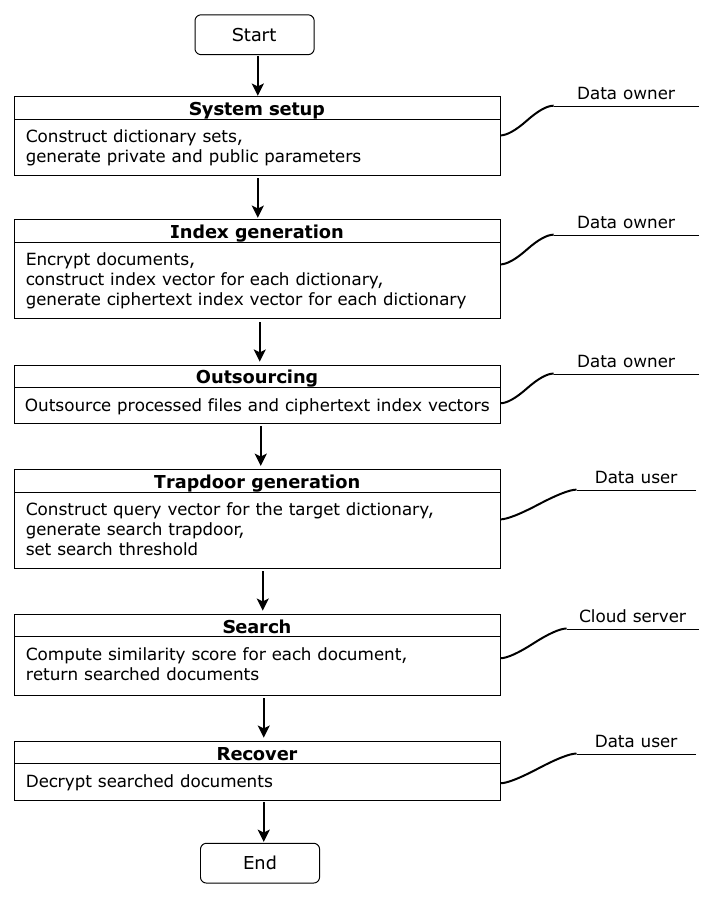
Figure 5. The flow chart of the extended PRMS